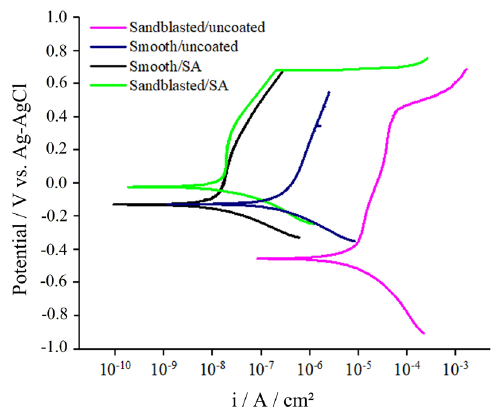
Figure 6. Polarization Curves of samples with smooth and sandblasted surface coated with SA compared with the uncoated samples analyzed in 0.1 mol / L of NaCl solution.